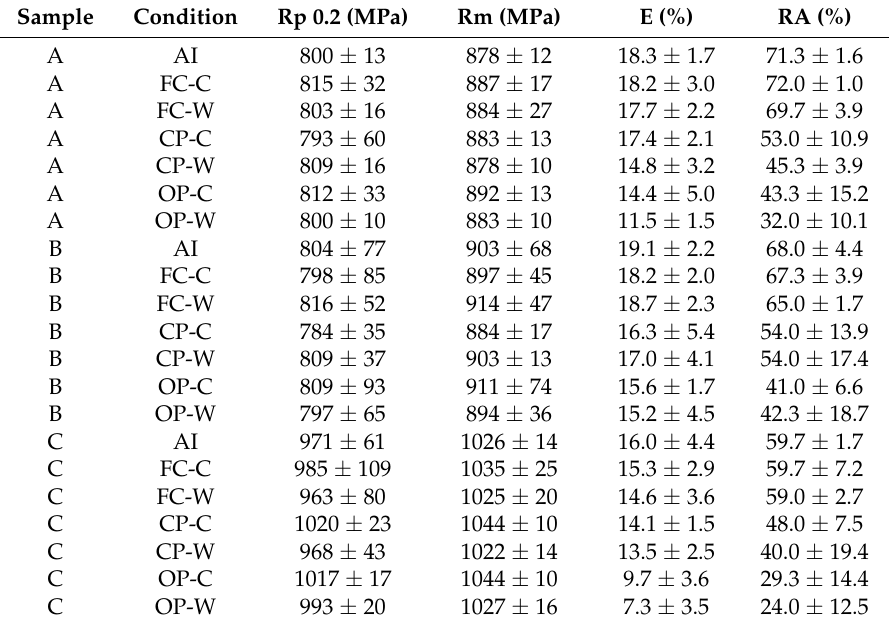
Table 5. Average of the mechanical properties measured by SSRT on the three